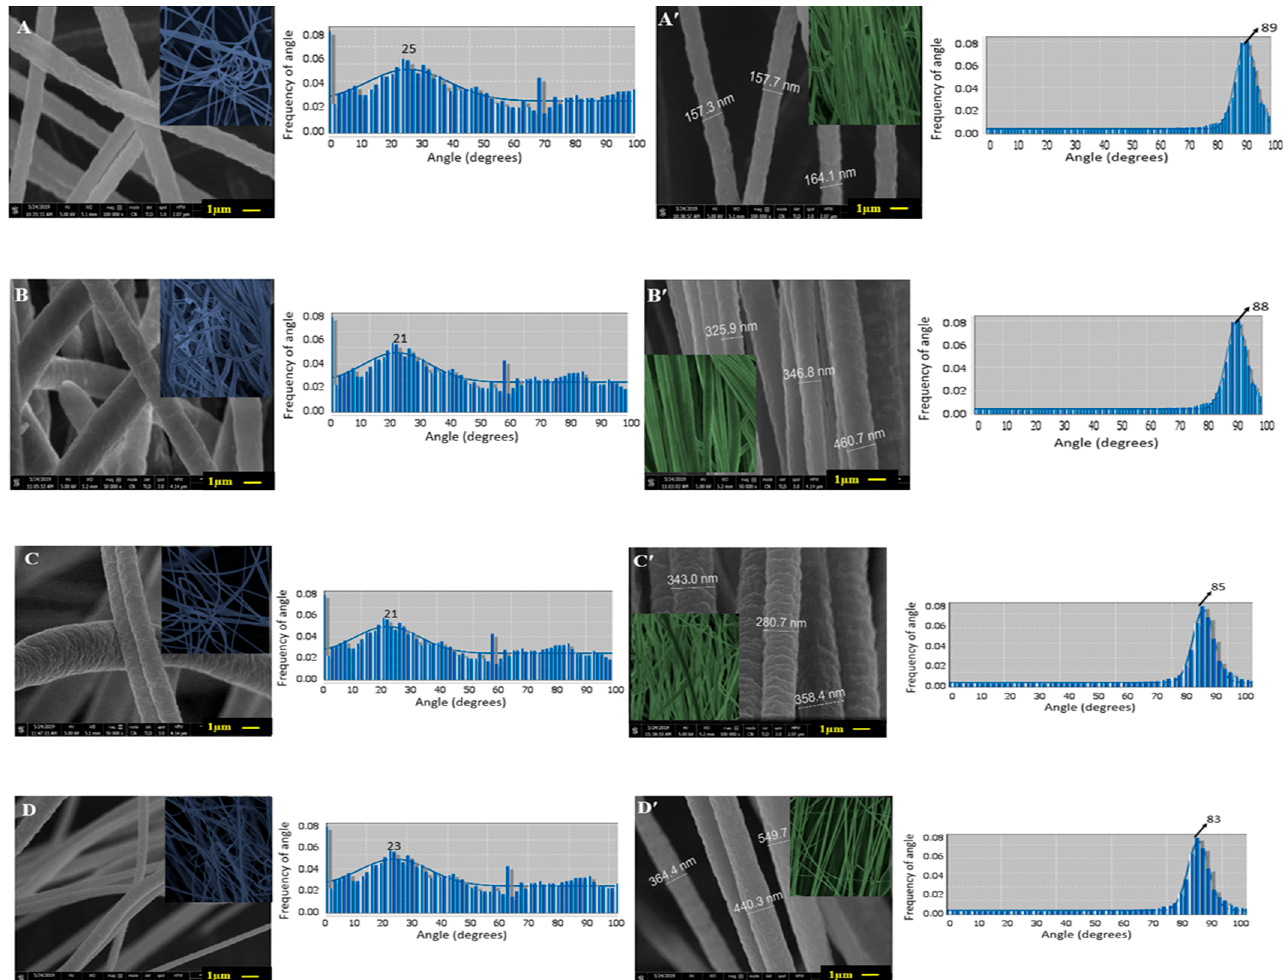
Figure 2. SEM micrographs and corresponding frequency distribution of orientation angles of nanofibrous structures: PAN ( A : not aligned; A’ : aligned); PLGA ( B : not aligned; B’ : aligned); PCA ( C : not aligned; C’ : aligned); PLA ( D : not aligned; D’ : aligned).